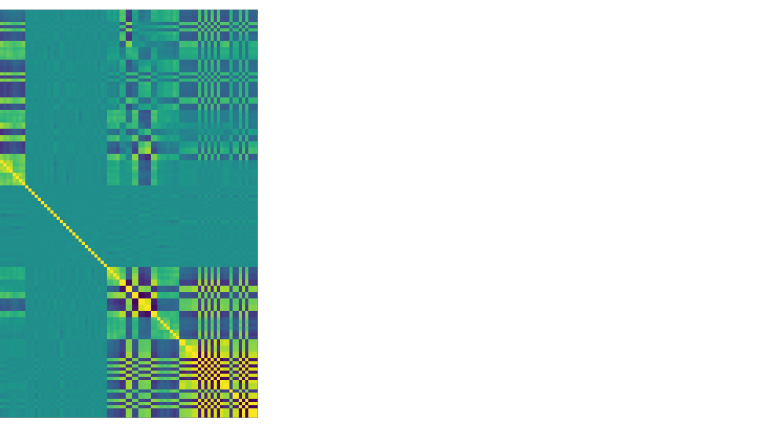
Figure 5. The correlation between features from Hierarchical Clustering (HC). The X and Y axis represent the same set of features listed in the same order. Please note that this order is based on the result of HC. Lighter color indicates stronger